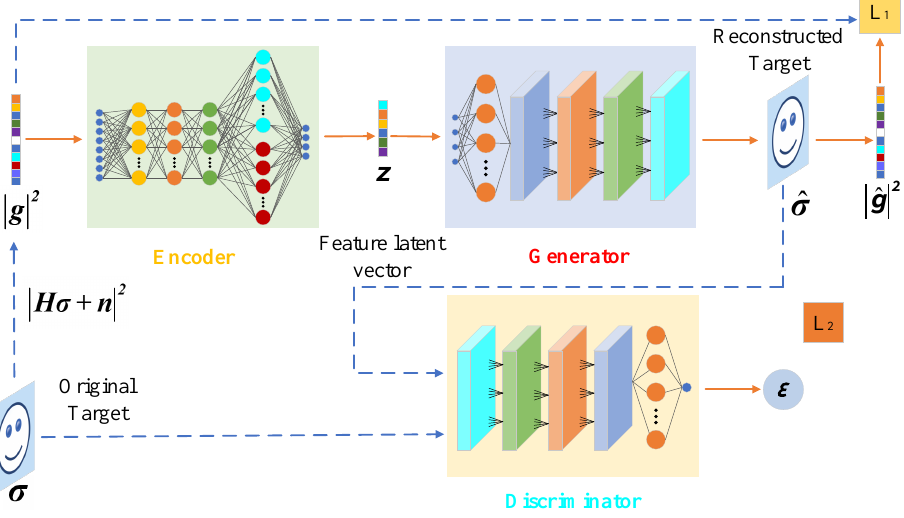
Figure 2. Model diagram of